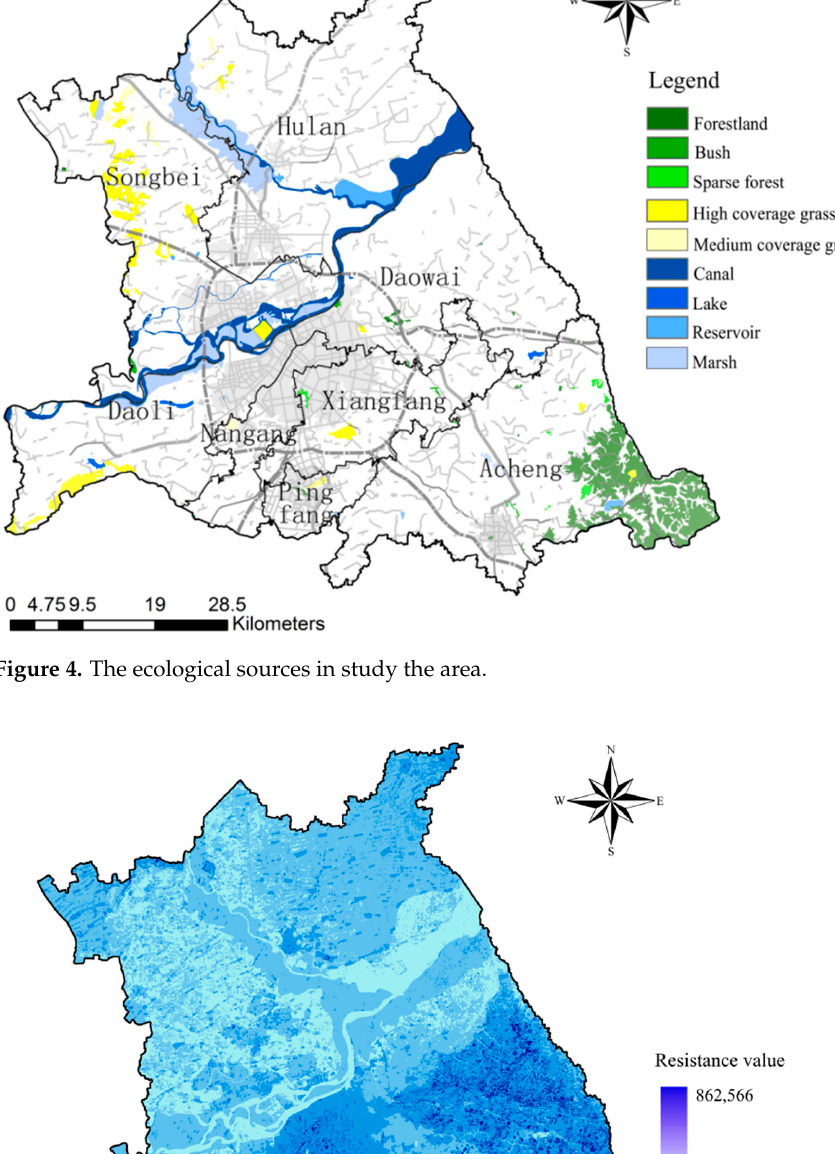
Figure 6. Ecological network in study the area. 3.3. Robustness Analysis of Ecological Network before and after Optimization 3.3.1. Robustness Analysis of Ecological Network before Optimization The initial value of the network connectivity robustness index before the optimiza- tion is 0.70, which has poor connectivity. Under intentional attack, the connectivity ro- bustness of the network decreases dramatically. When the number of removed nodes reaches 17, the connectivity robustness index of the network is less than 0.1, at this time, the network structure has been completely destroyed and the connectivity function of the